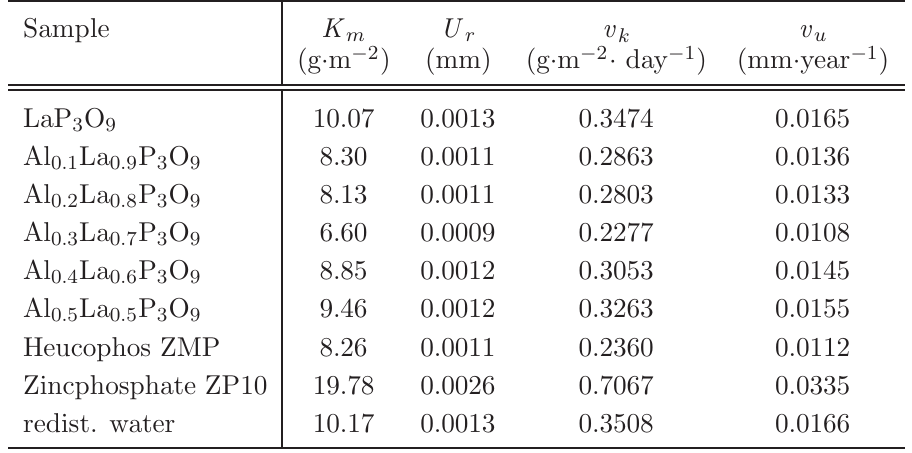
Table 2 Corrosive decreases of steel plates in aqueous extract of